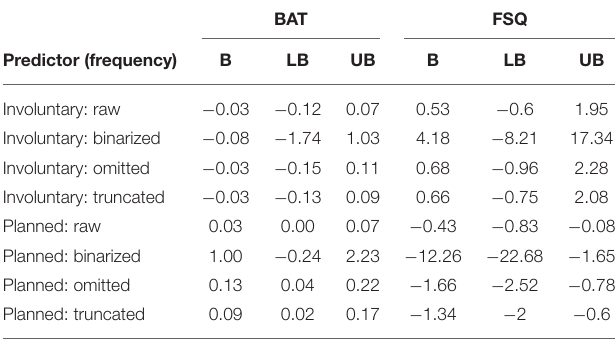
TABLE 1 | Independent impact of exposure frequencies in longitudinal